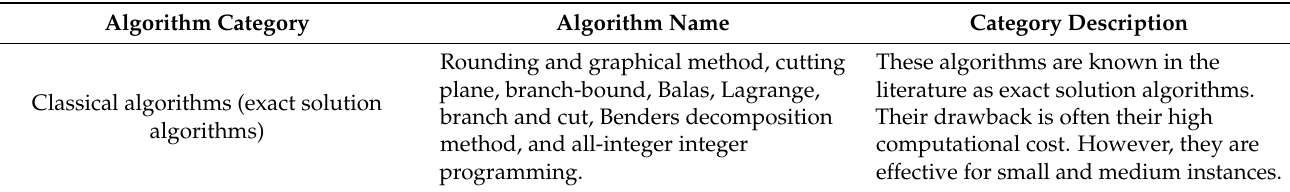
Table 4. Algorithm classifications and